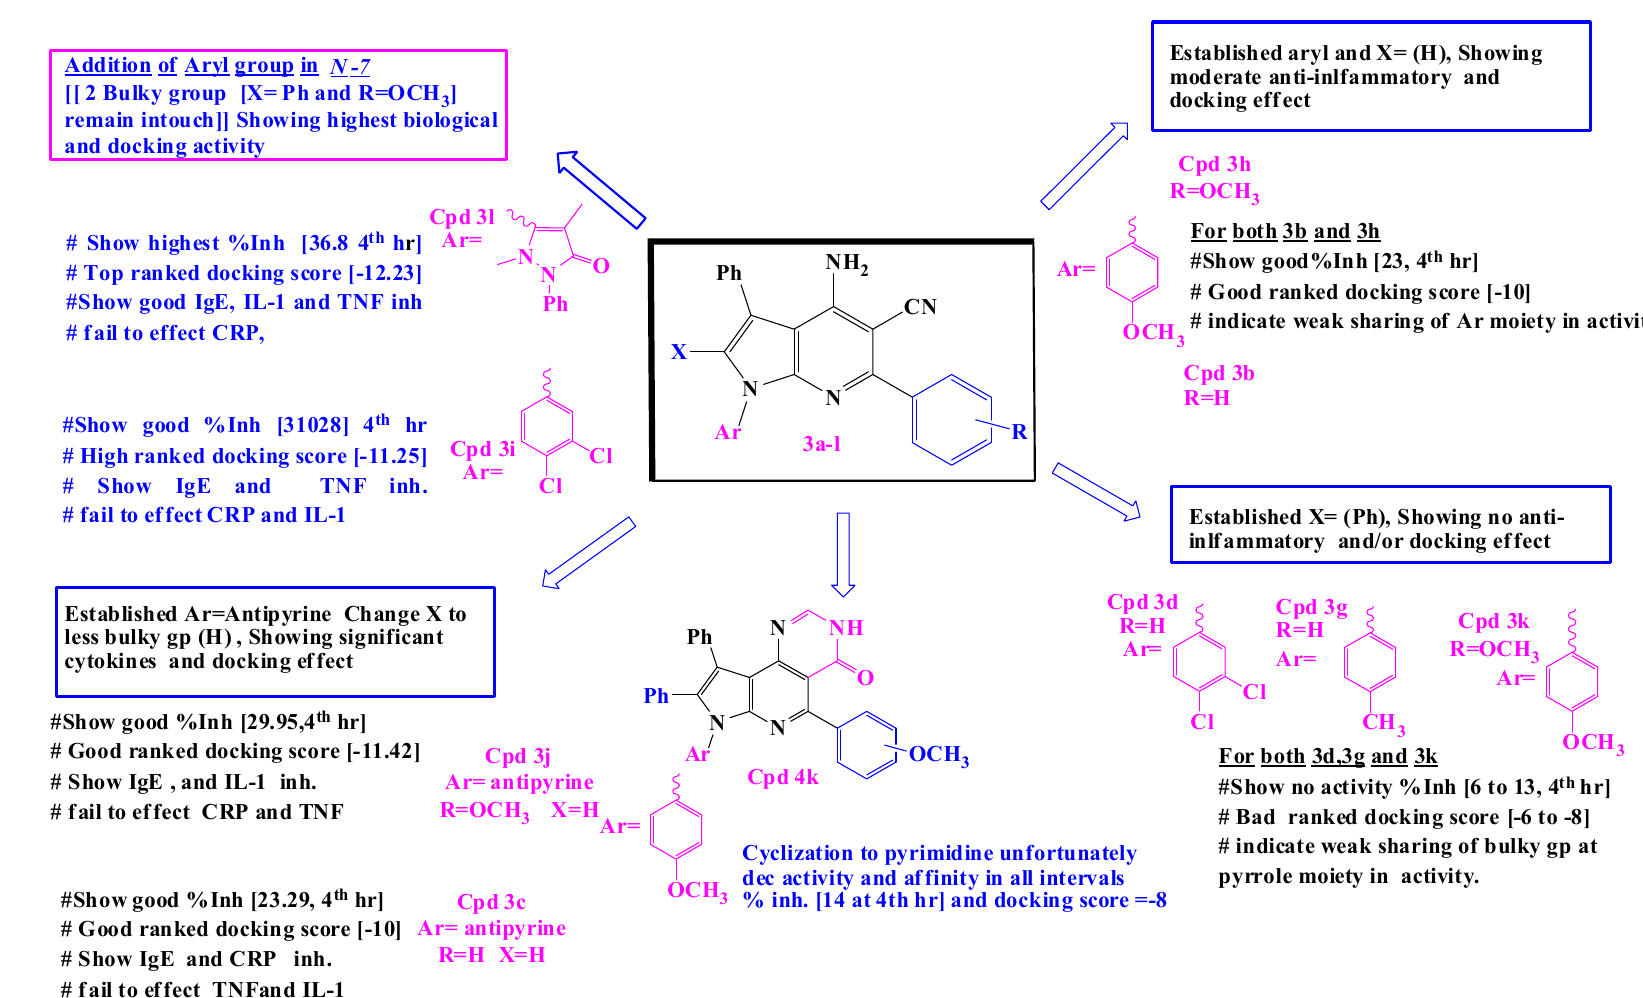
Figure 4. SAR and discussion for all bioassay and docking studies performed on the tested compounds.